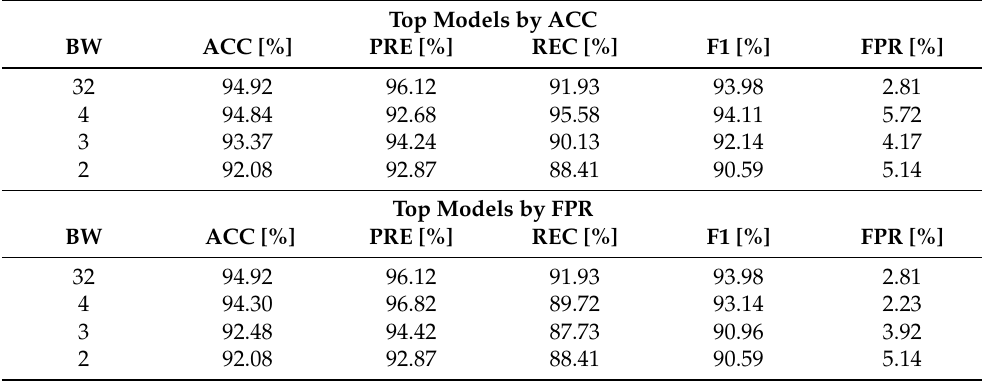
Table 6. Results of cloud coverage classification for best-performed models using L8-D dataset excluding Snow/Ice